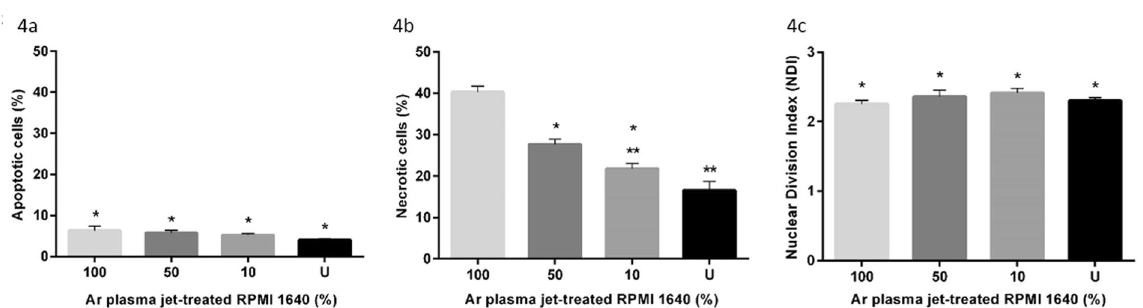
Figure 4. Cytotoxicity of untreated (U) RPMI 1640 and Ar plasma jet-treated RPMI 1640 (at concentrations of 10, 50 and 100%): ( a ) percentage of apoptotic cells, ( b ) percentage of necrotic cells, and ( c ) Nuclear Division Cytotoxic Index (NDI). Experiments were performed in triplicate with triplicate samples per experiment ( n = 9). Each point represents the mean value and ± standard error of the mean (SEM) of all repeats. One- way ANOVA was used to determine the statistical significance of the values. The values without a mark above indicate that they are statistically significantly different whereas the values sharing * or ** are not ( P <